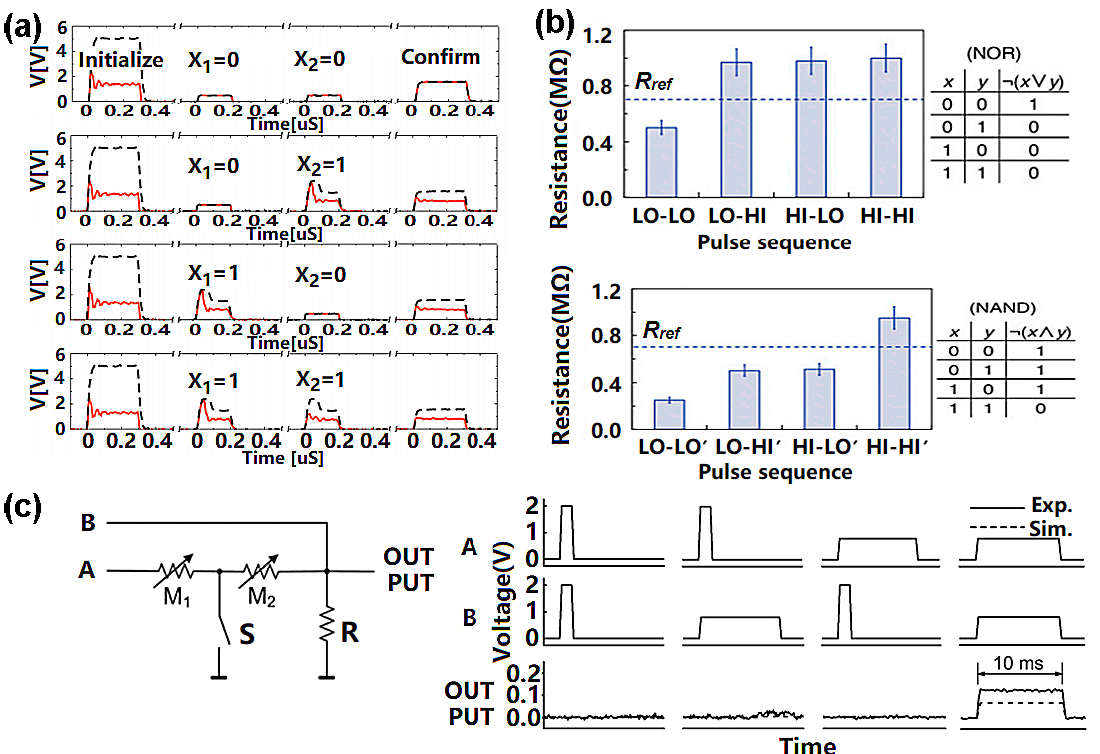
Figure 10. PCRAM-based logic operations: ( a ) measuring the applied voltage and voltage across the cell during initialization and computing for the four cases for logic inputs X 1 and X 2 ; ( b ) cell resistance with respect to the pulse sequence for NOR and NAND operations, respectively; ( c ) the AND setup and its corresponding voltage output. (( a ) is reprinted with permission from [120]; ( b ) is reprinted with permission from [121]; ( c ) is reprinted with permission from [122].)